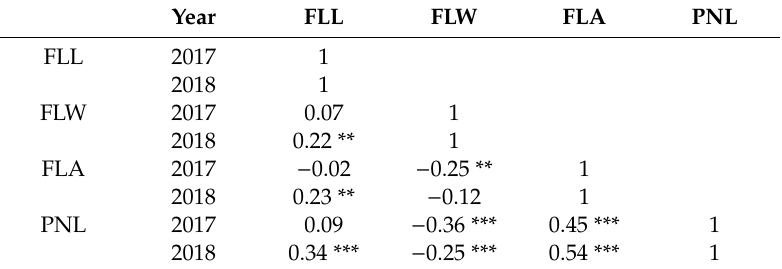
Table 3. The phenotypic Pearson correlation coe ffi cients among four phenotypic traits in the CL CSSL population. Year FLL FLW FLA PNL FLL 2017 1 1 FLW 0.07